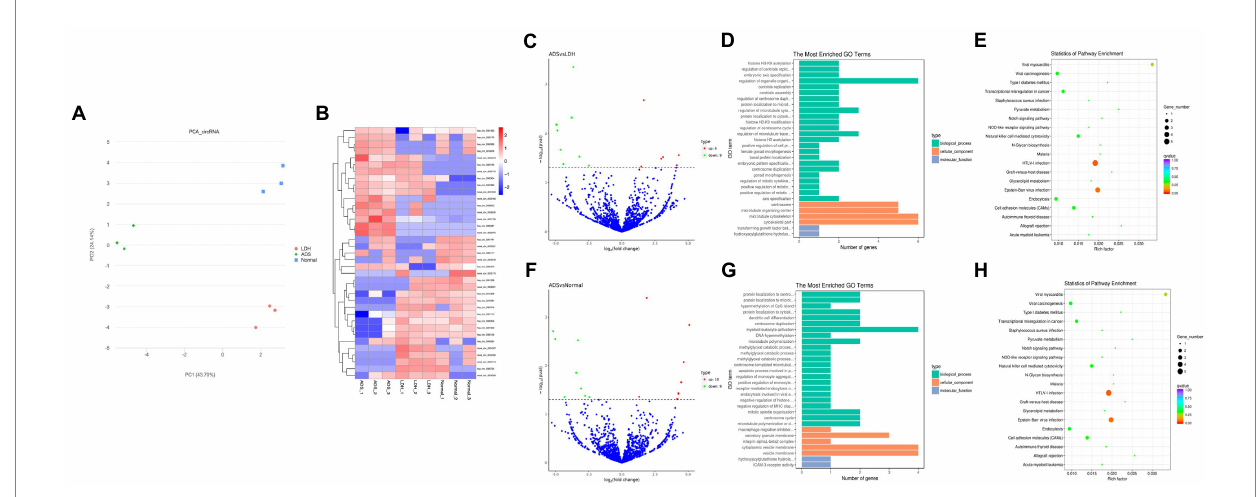
FIGURE 5 Identification of differentially expressed circRNAs in ADS (A) Principal component analysis shows the clustering of circRNA in different samples. (B) Hierarchical clustering illustrates distinguished expression differences of circRNA and between the three groups and homogeneity between groups. (C) Volcano plot showing differentially expressed circRNAs in ADS and LDH group. (D) The 20 most enriched Gene Ontology terms for the parental genes of the differentially expressed circRNAs in ADS and LDH group. (E) The 20 most enriched KEGG pathways for the differentially expressed circRNAs in ADS and LDH group. (F) Volcano plot showing differentially expressed circRNAs in ADS and Normal group. (G) The 20 most enriched Gene Ontology terms for the parental genes of the differentially expressed circRNAs in ADS and Normal group. (H) The 20 most enriched KEGG pathways for the differentially expressed circRNAs in ADS and Normal group. Enriched GO terms are on the vertical axis, and the number of annotated differentially expressed genes associated with each GO term is indicated on the horizontal axis. The size of the symbol represents the number of genes, and the colors represent p -value in KEGG.